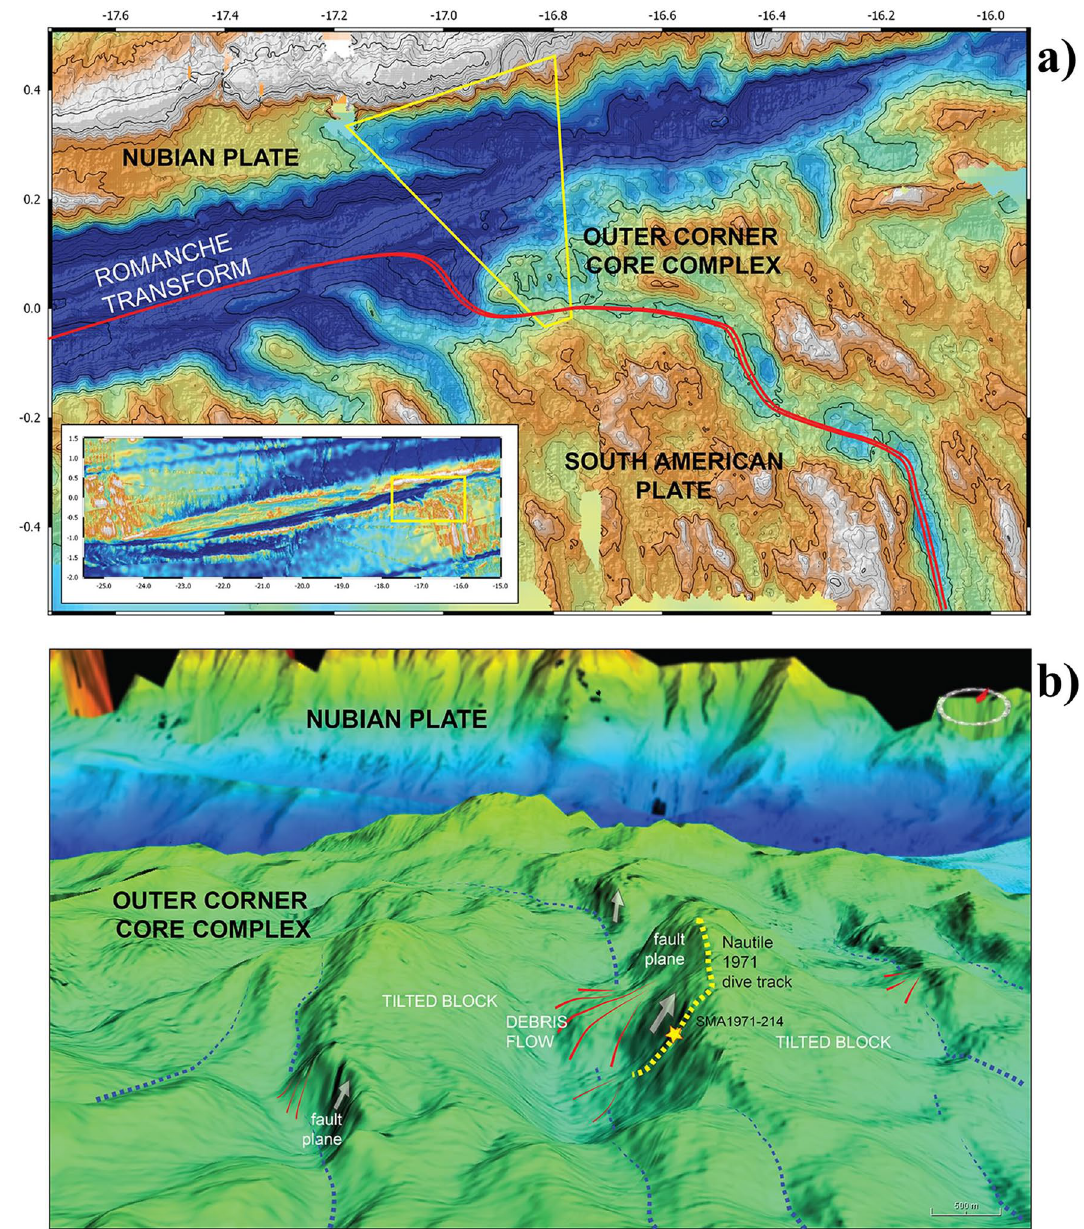
Figure 1. ( a ) Bathymetry of the eastern intersection of the Romanche Fracture with the Mid Atlantic Ridge, ( b ) 3-D reconstruction of the area in (yellow region in a ). Topographic features have been observed during the Nautile dive SMA1971 in the oceanic cruise SMARTIES, 2019. Position of sample SMA1971-214 (yellow star) is reported along the Nautile dive track (yellow dot line). Bathymetry and 3D rendering have been generated from shipborne multibeam echosounding data acquired during the SMARTIES cruise 15 . Data were acquired with a Reson Seabat 7150 echosounder, using 880 beams at 12/24 kHz with an average swath of 12 km. Data were processed with the Globe software by IFREMER 65 single component whereas the ferrous Site 2, by two components. Site 1 shows parameters typical of ferric in a distorted octahedral environment, and it can be reasonably ascribed to lizardite and chlorite. Concerning Site 2, QSD highlights the presence of a binomial distribution of Δ showing two maxima at 2.73 and 1.79 mm/s respectively. The hyperfine parameters are reported in Supplementary Table S3. The values of 〈 Δ 〉 are typical of distorted octahedral sites, and they can be attributed to ferrous nuclei contained in tremolite and, eventually, within accessory phases 20,21 . Unfortunately, the impossibility to separate these contributions does not allow a rigorous correlation between the ferrous population and the tremolite crystallographic sites. The structural formula derived from major element EPMA analyses can be expressed as: